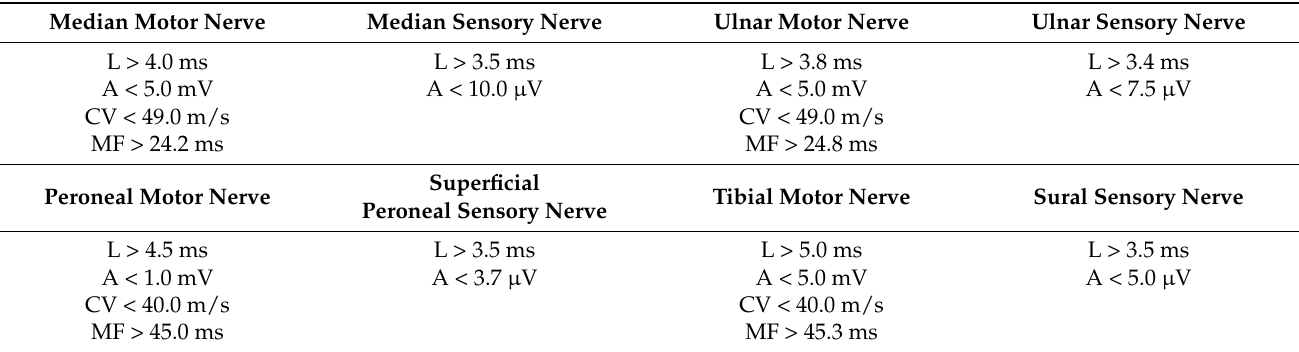
Table 1. Electrophysiological criteria for abnormal nerve conduction study.